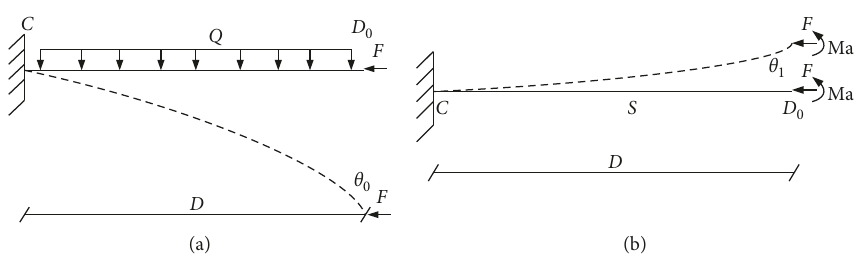
Figure 4: Decomposition of the mechanical state regarding a statically indeterminate structure.